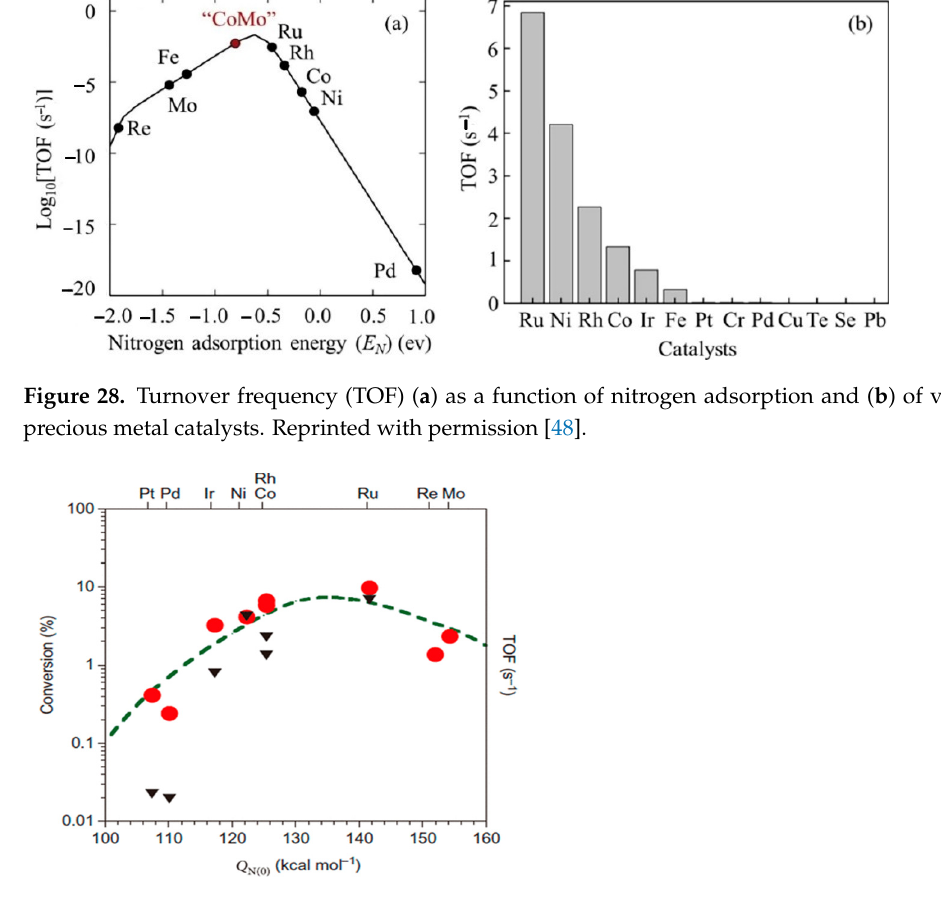
Figure 30. Ru-based catalysts for ammonia decomposition. Reprinted with permission [115].